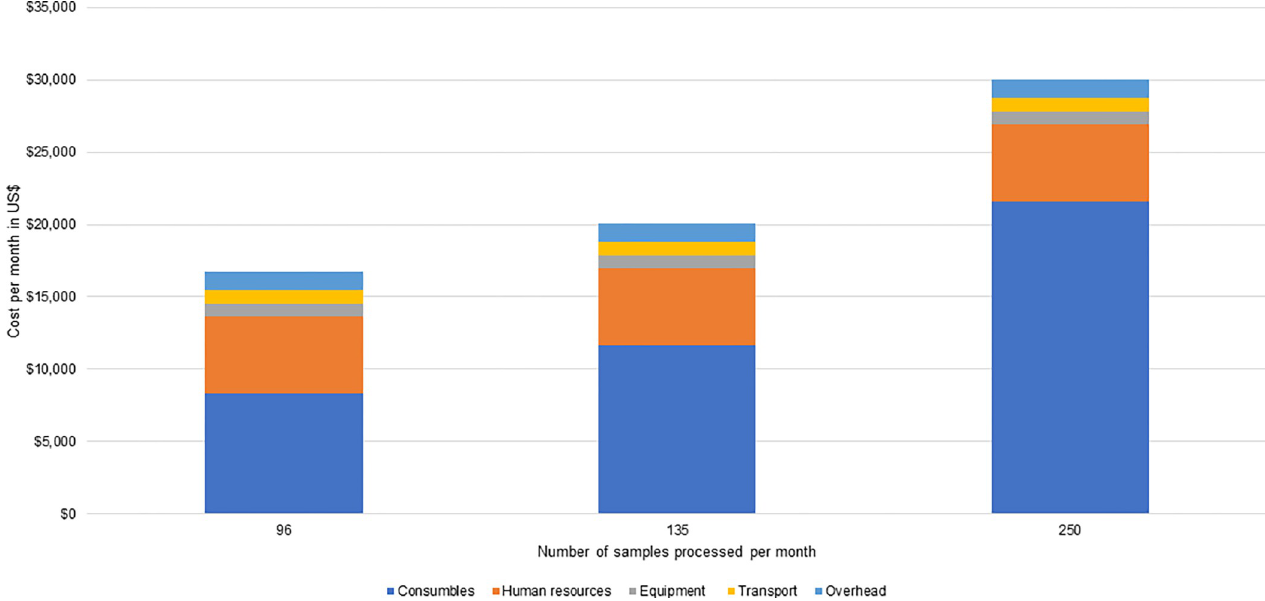
Fig 2. Monthly costs for SARS-CoV-2 ES in 2021 US$ at the Kathmandu pilot site.